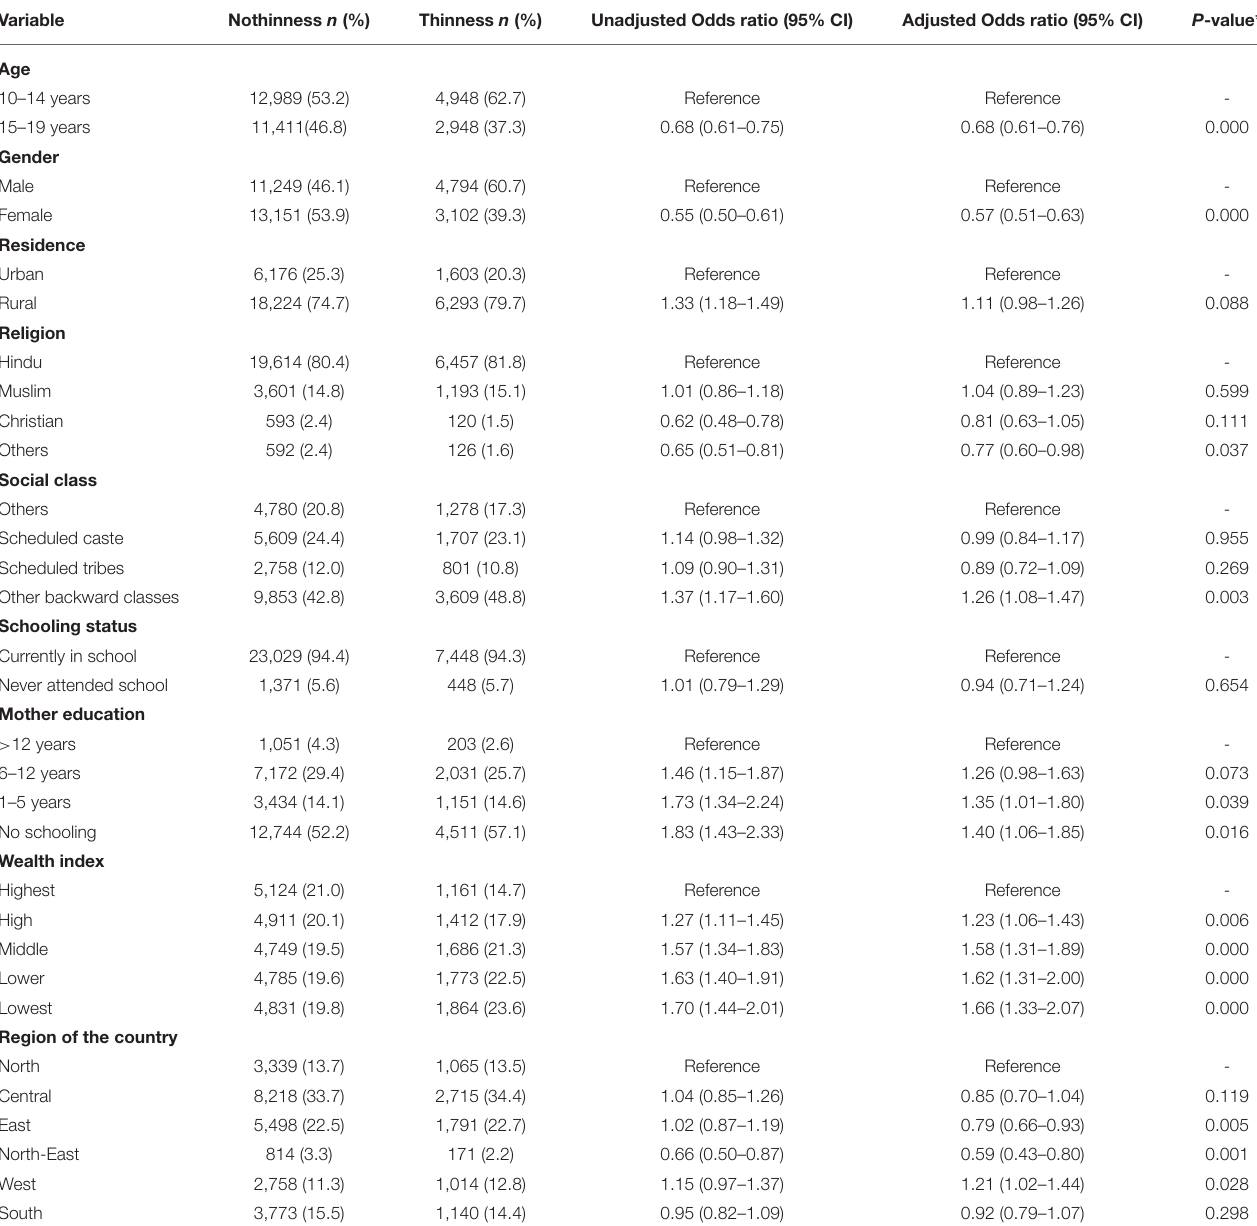
TABLE 3 | Predictors of Thinness among adolescent children (10–19 years) of India through Logistic regression model (weighted N = 32,296).